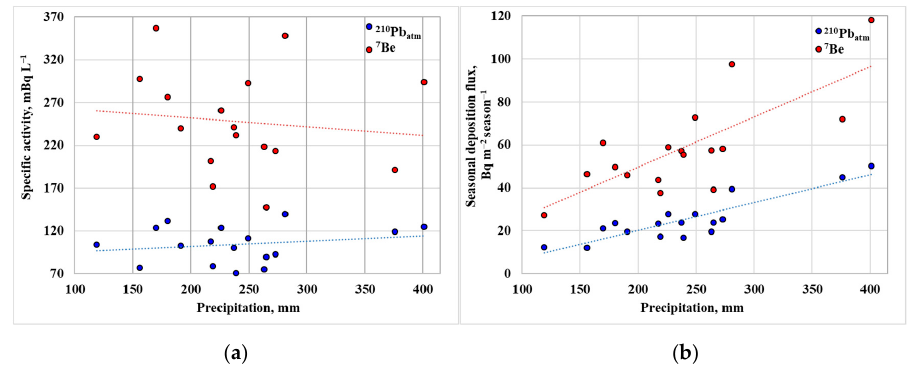
Figure 2. Dependence of specific activities ( a ) and seasonal deposition fluxes ( b ) of 7 Be and 210 Pb atm on the calculated amount of precipitation at the sampling points.